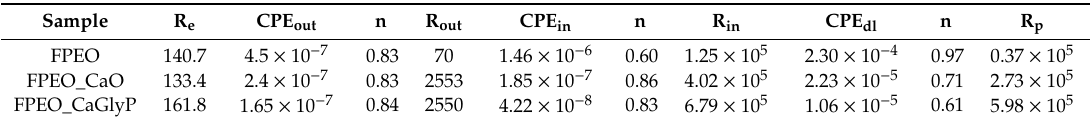
Table 7. Fitted parameters of the EIS data for the PEO coatings after 30 min of immersion in 0.5% wt. NaCl. (R given in Ω cm 2 ; CPE given in S s − n cm − 2 ).